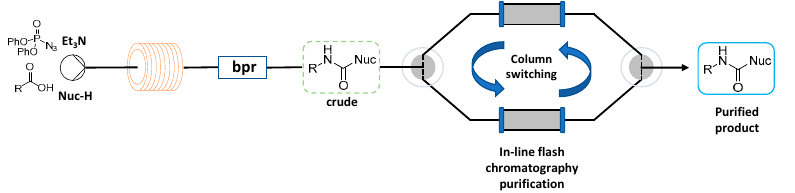
Figure 1. Continuous DPPA-mediated Curtius rearrangement procedure with in-line flash chromatography.